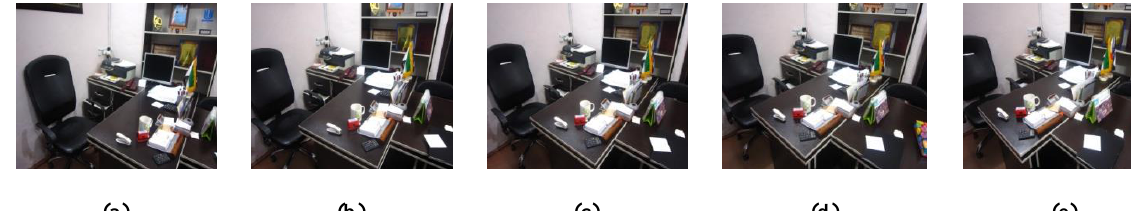
Figure. 12. Different views of "Office 1".